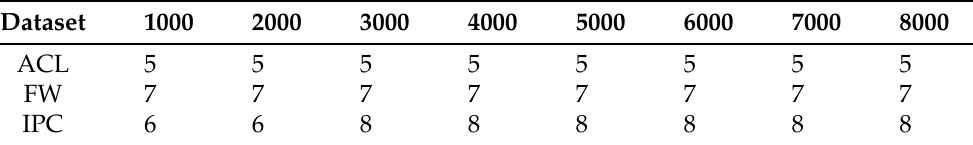
Table 3. Performance of different Form Switch thresholds (AVE Form threshold: 2000, WC Form threshold: